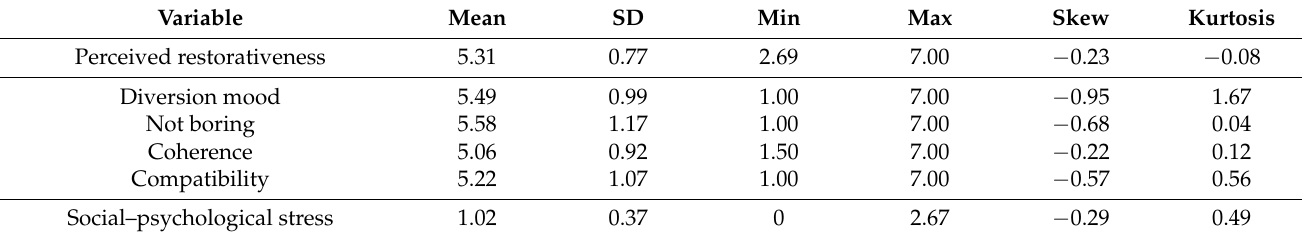
Table 3. Technical statistics of perceived restorativeness and social · psychological stress